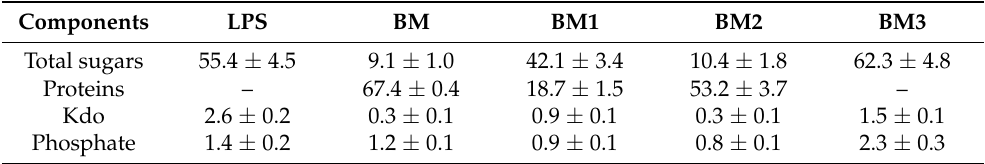
Table 1. The chemical composition (contents of components in wt.%) of the biofilm matrix (BM), its fractions (BM1, BM2 and BM3), as well as of the LPS from A. baldaniorum Sp245.